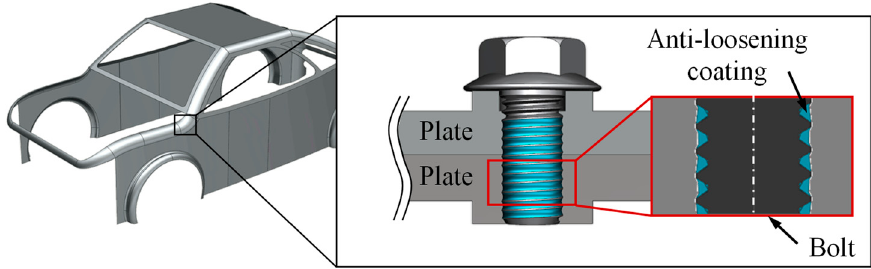
Figure 1. Automotive parts fastening with anti-loosening coated bolts.